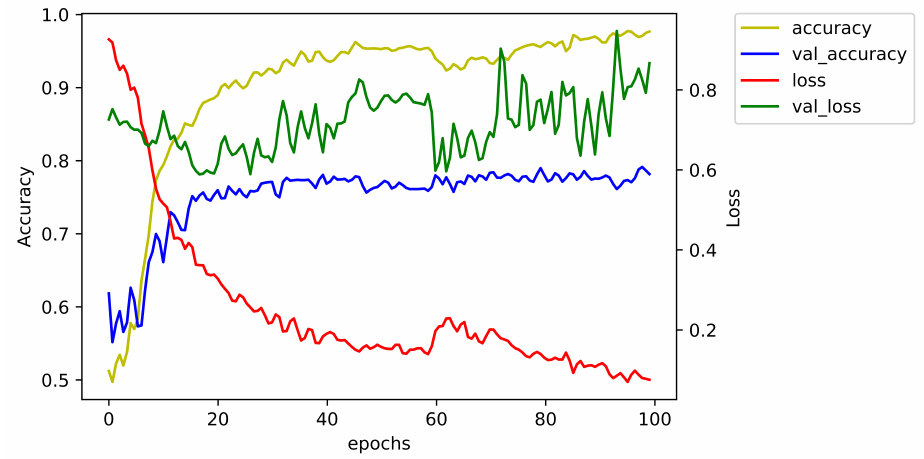
Figure 5. Accuracy and loss in 100 training